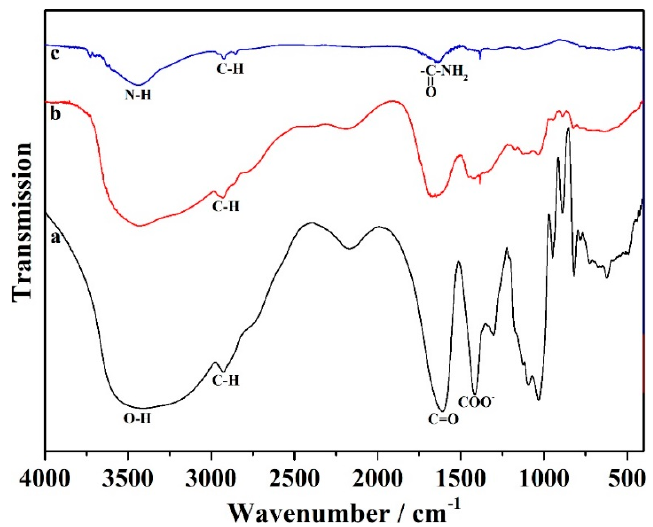
Figure 1. Infrared spectra of ( a ) raw sodium alginate, ( b ) alginate/polyacrylamide composite aerogel (Alg–PAM), and ( c ) raw polyacrylamide.